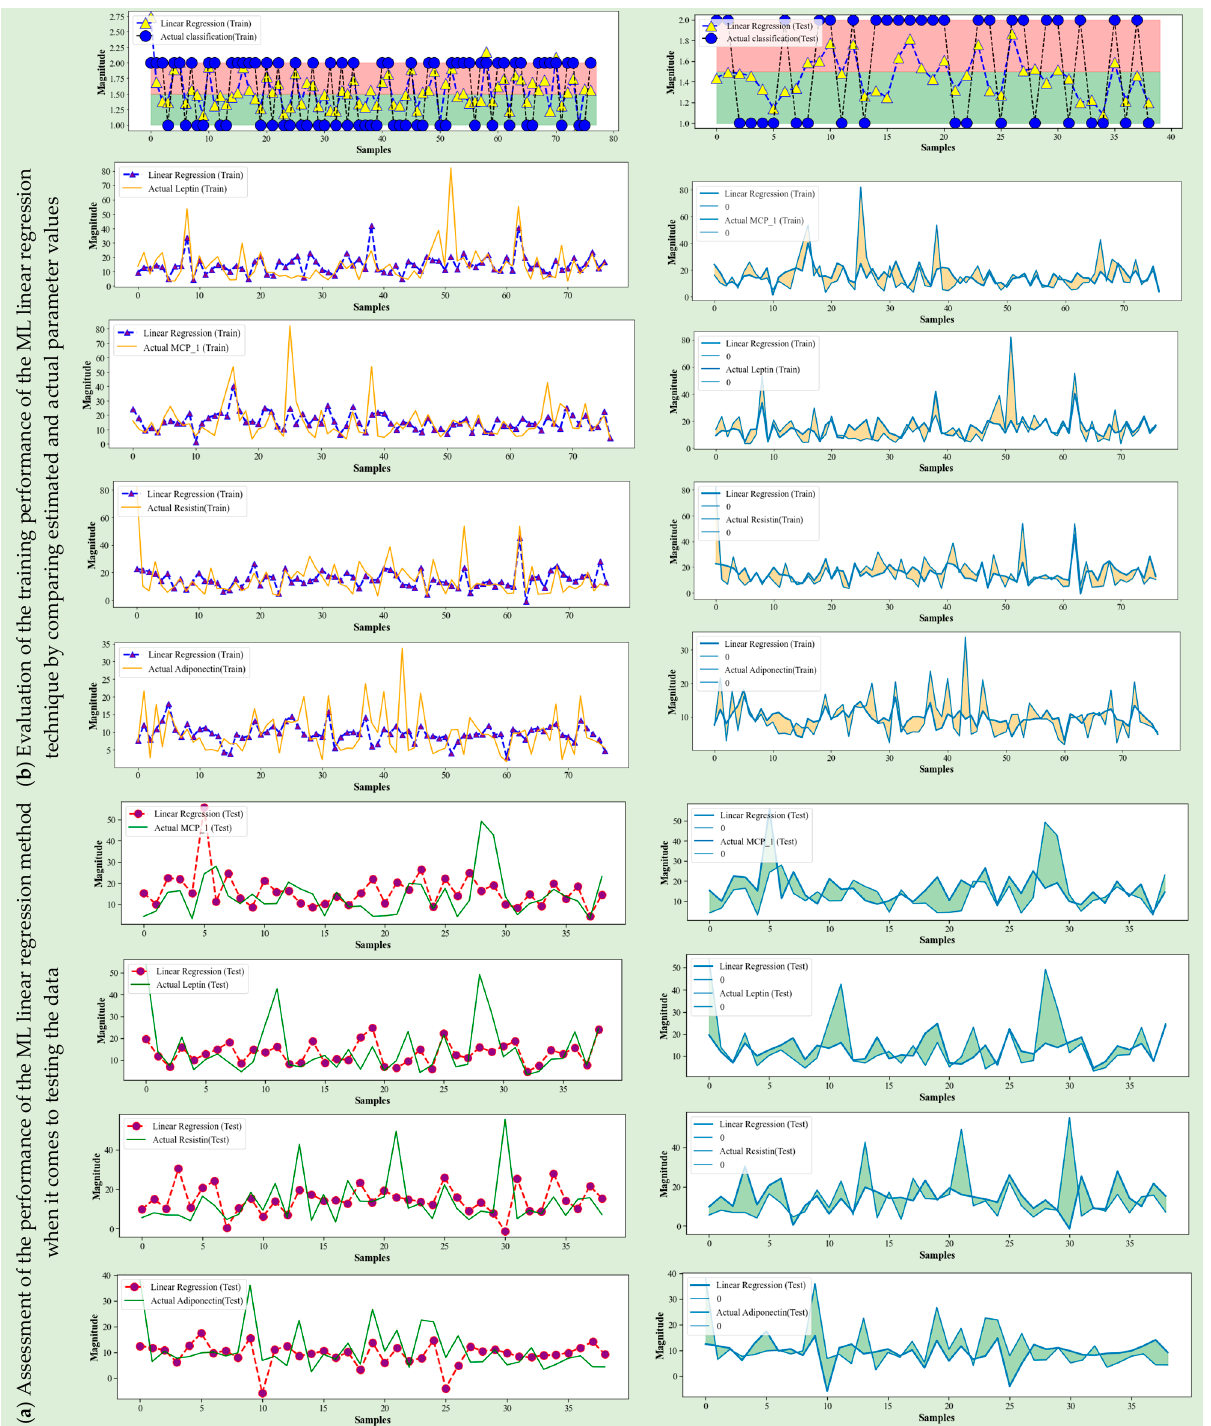
Figure 2. The procedure of identifying breast cancer is illustrated for both the training and testing data based on ML linear regression. ( a ) The e ff ectiveness of the procedure is measured using the training data. ( b ) The procedure’s performance is assessed using the testing data.